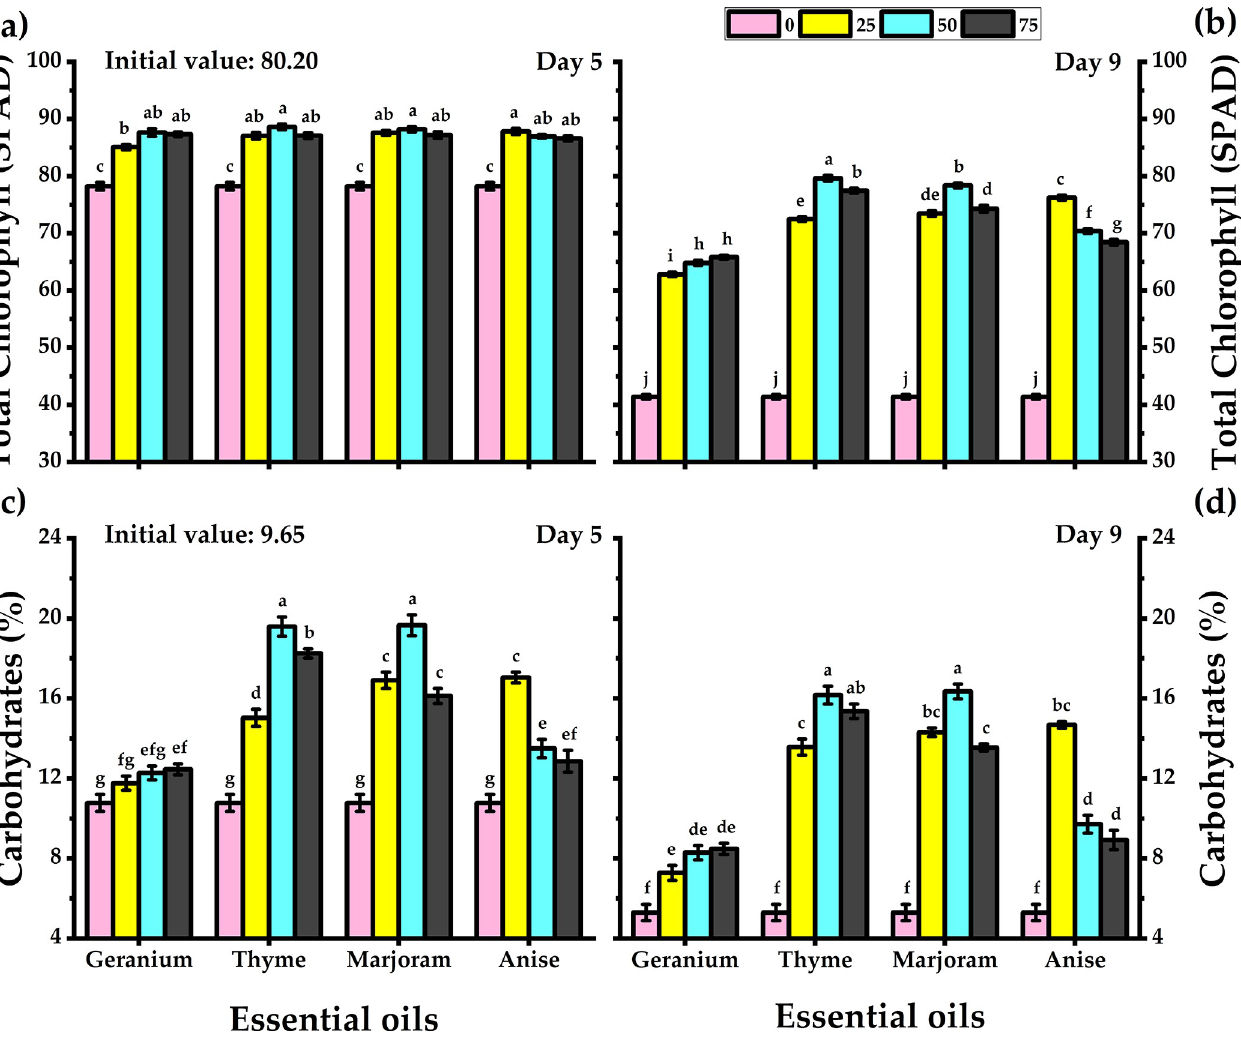
Fig 4. Response of carnation cut flowers to geranium, thyme, marjoram, and anise essential oils at 0, 25, 50, and 75 mg/L concentrations as preservative solutions on the total chlorophyll (a, b), and carbohydrates content (c, d) at day 5 and day 9 of vase life period. Bars with the same letters are not significantly differed at p � 0.05